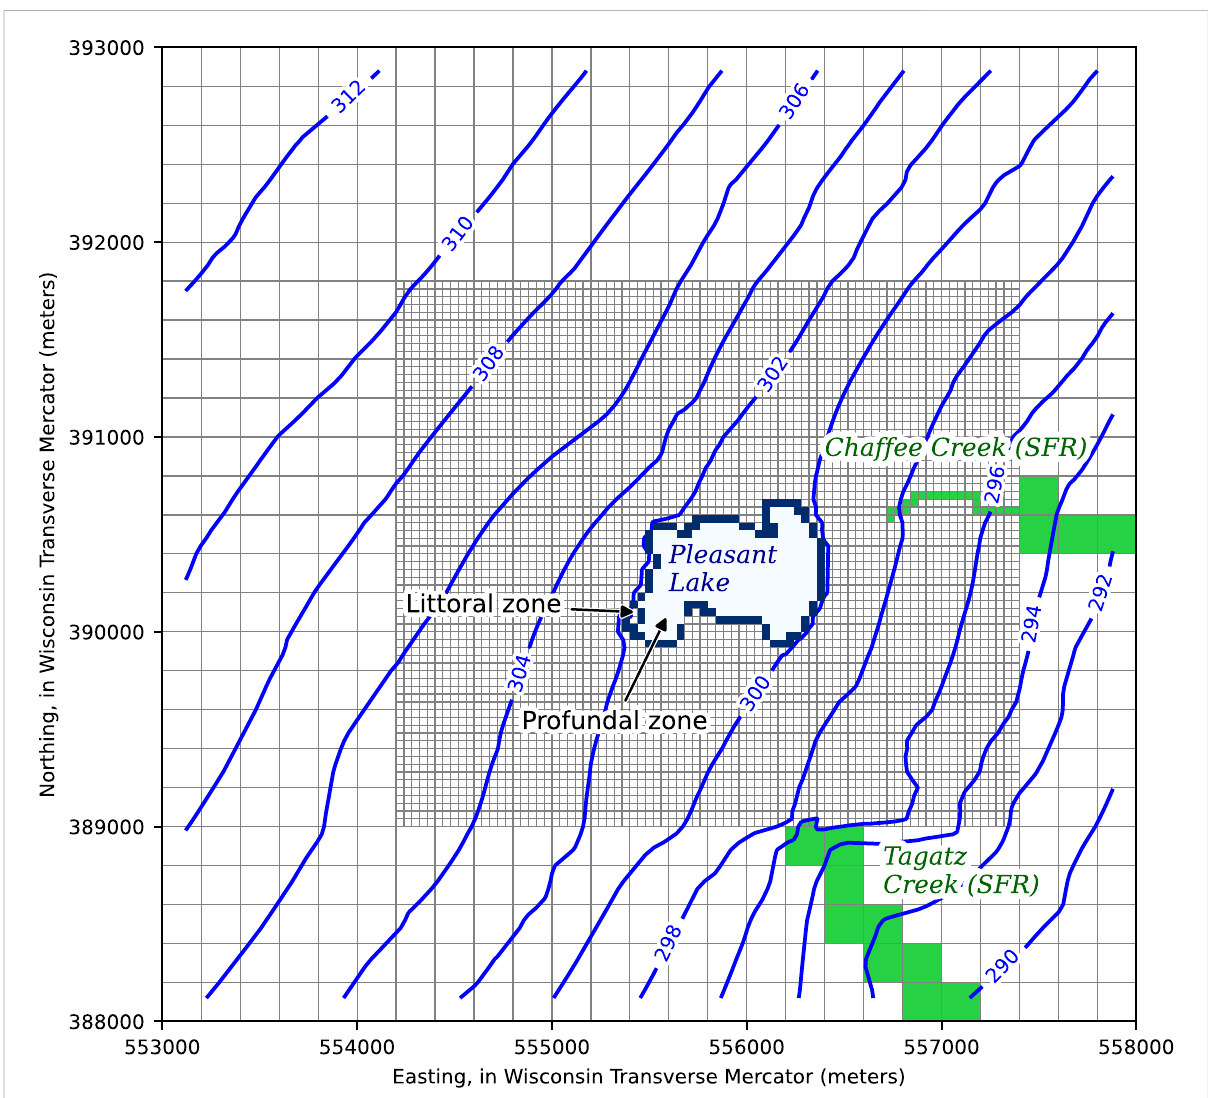
FIGURE 3 Close-upoftheexamplelocalgridre fi nementinsetmodelcon fi guration,showingthediscretizationandcombinedwatertablesolution,aswell as Stream fl ow Routing (SFR) Package cells and the littoral and profundal lakebed leakance